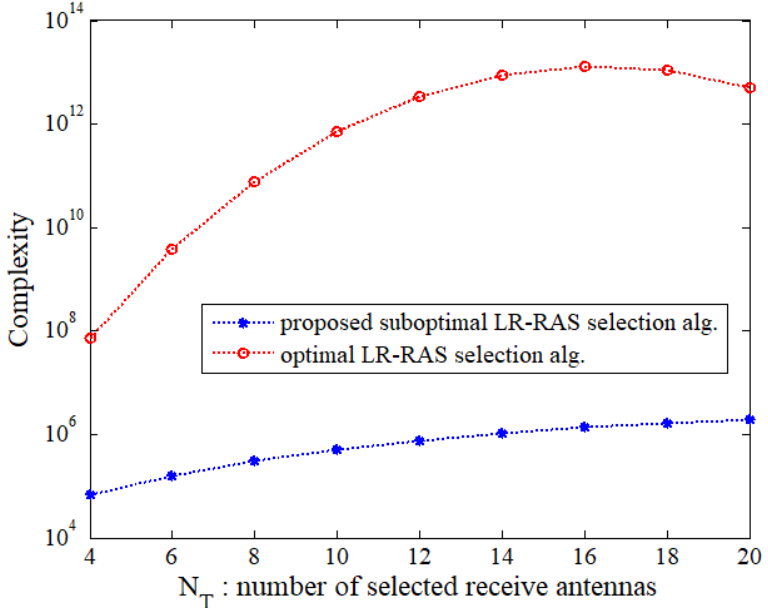
Figure 6. Complexity comparison of the proposed algorithm and optimal one for N R = 30 and N iter = 3 .